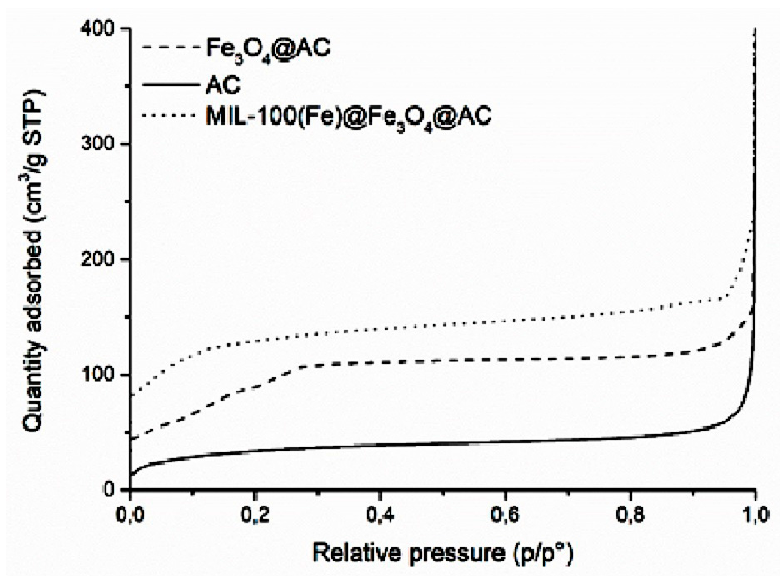
Figure 2. N 2 adsorption-desorption isotherms of AC, Fe 3 O 4 @AC, and MIL-100(Fe) @Fe 3 O 4 @AC absorbents at 77 K.